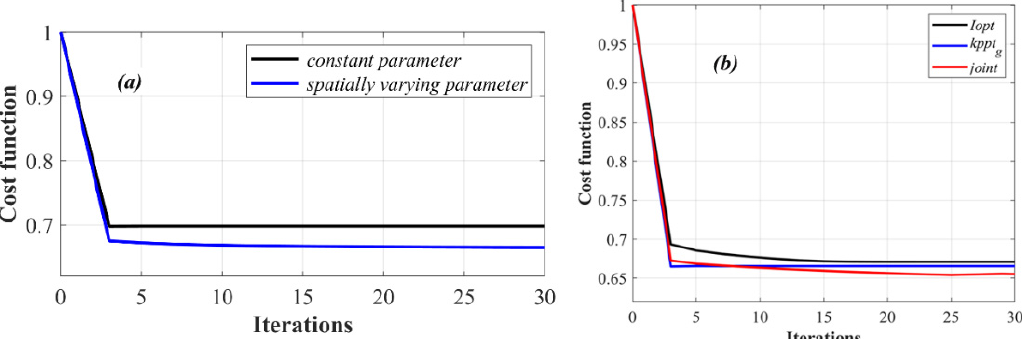
Figure 7. The optimization results of the case study. ( a ) The values of normalized cost function versus the assimilation iterations for the optimization of constant parameters and spatially varying parameters, and ( b ) for the optimization of different sensitive spatially varying parameters.